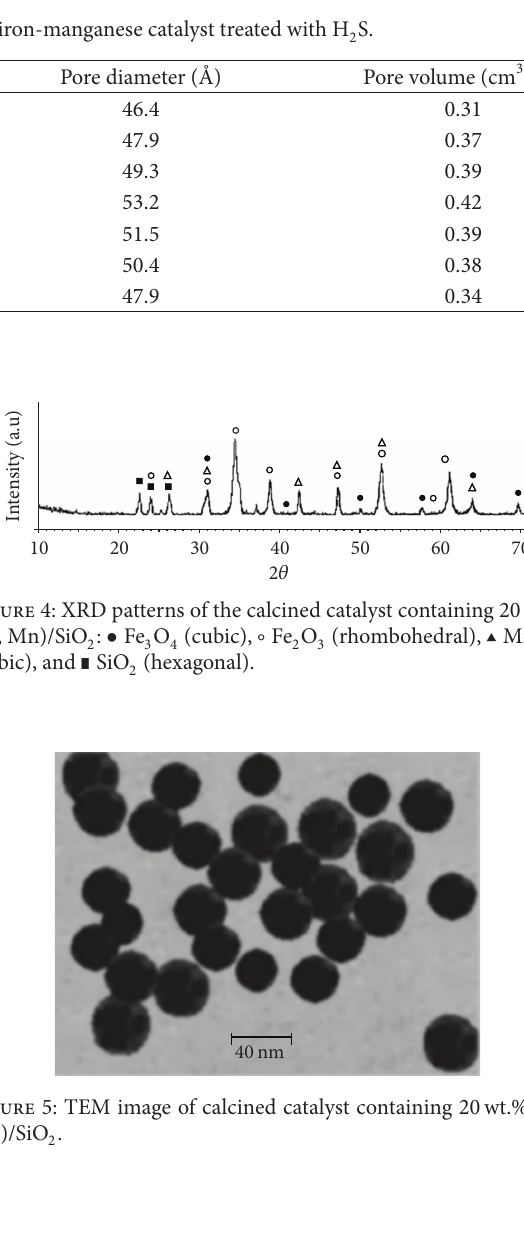
F 3: SEM images of precursor (a) and calcined catalyst containing 20wt.